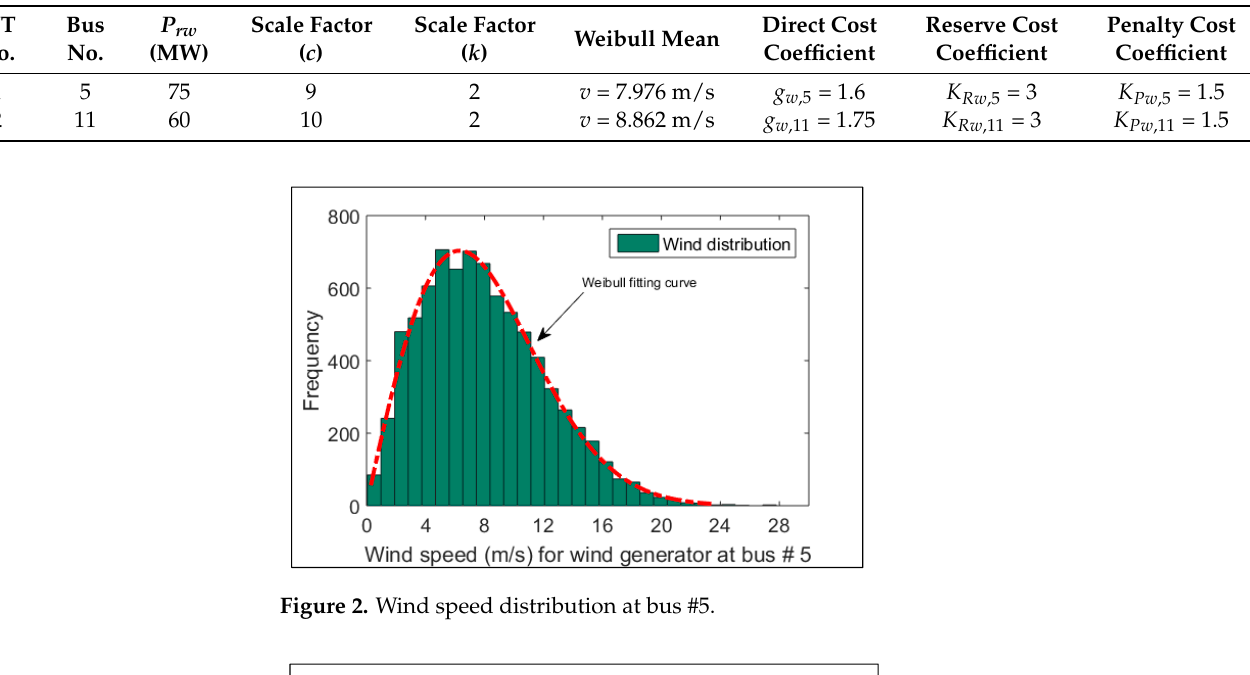
Table 3. WT PDF parameters and cost coefficients.